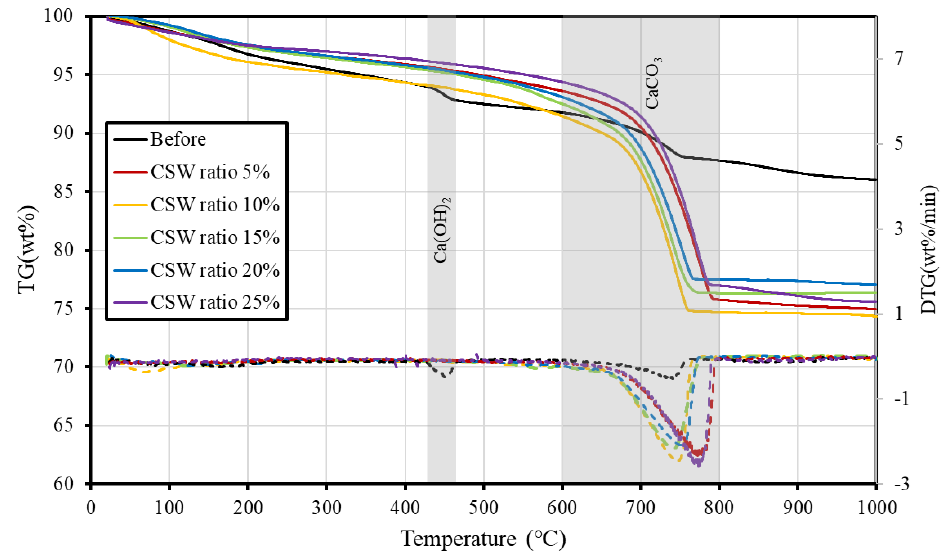
Figure 7. TG-DTG results (solid line : TG, dashed line : DTG)